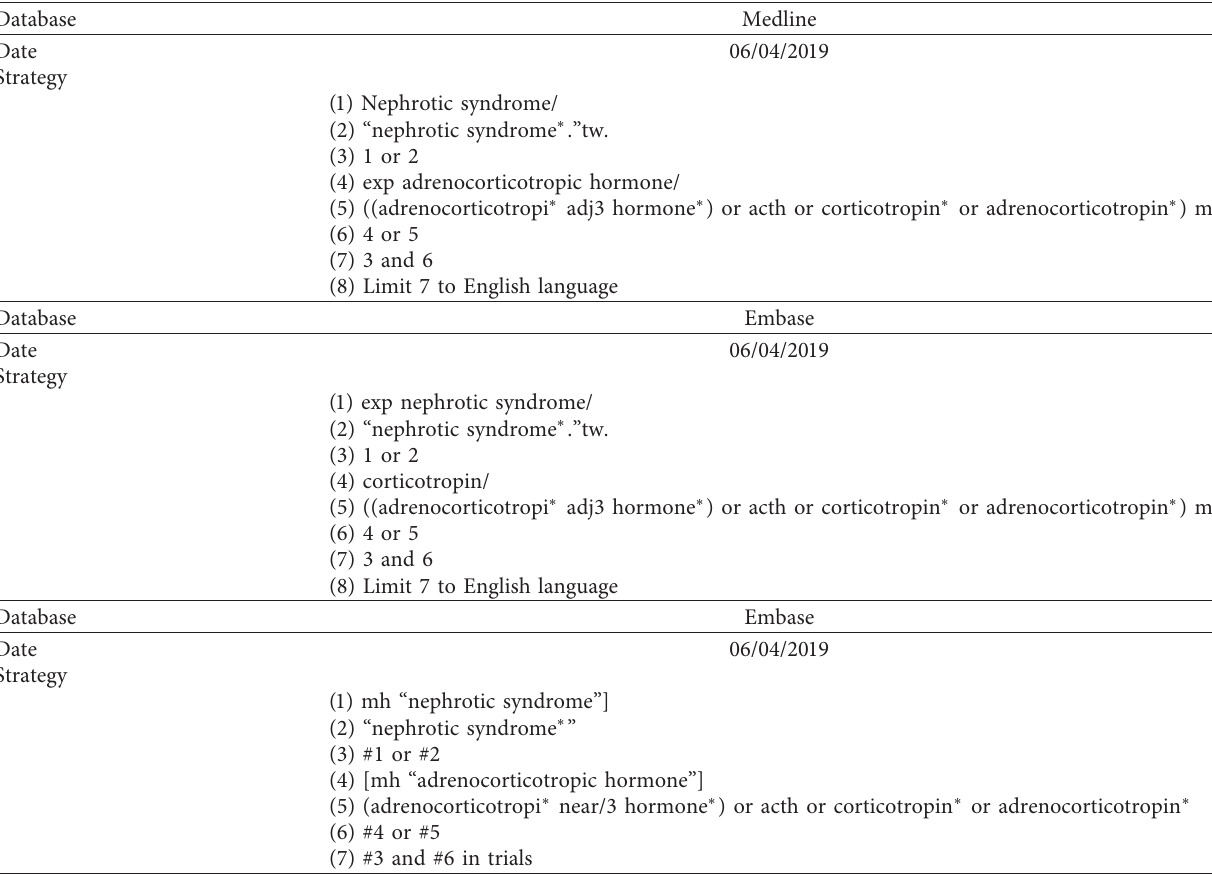
Table 1: Search strategy.